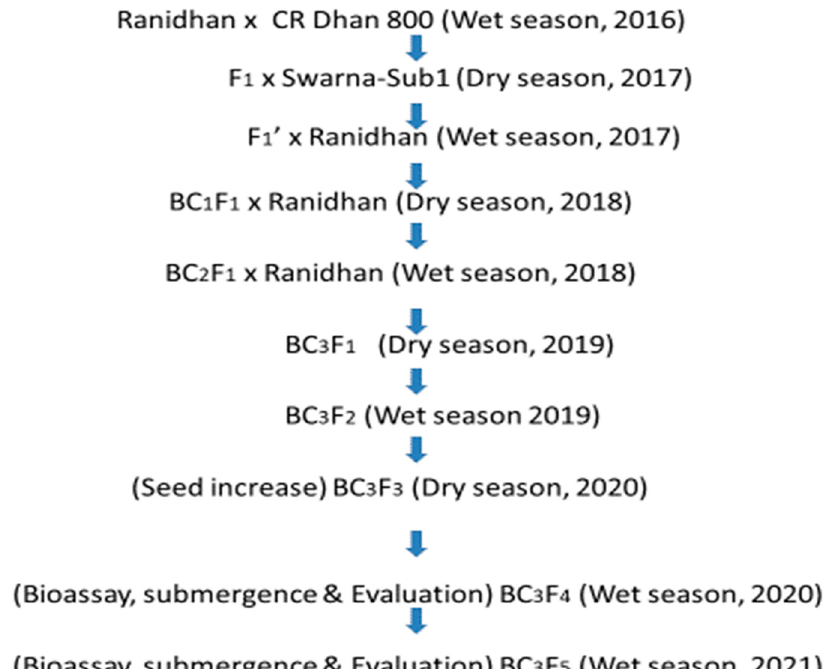
Figure 1. Marker-assisted breeding flowchart for transfer of submergence tolerance and bacterial blight resistance into the high-yielding popular variety “Ranidhan”.